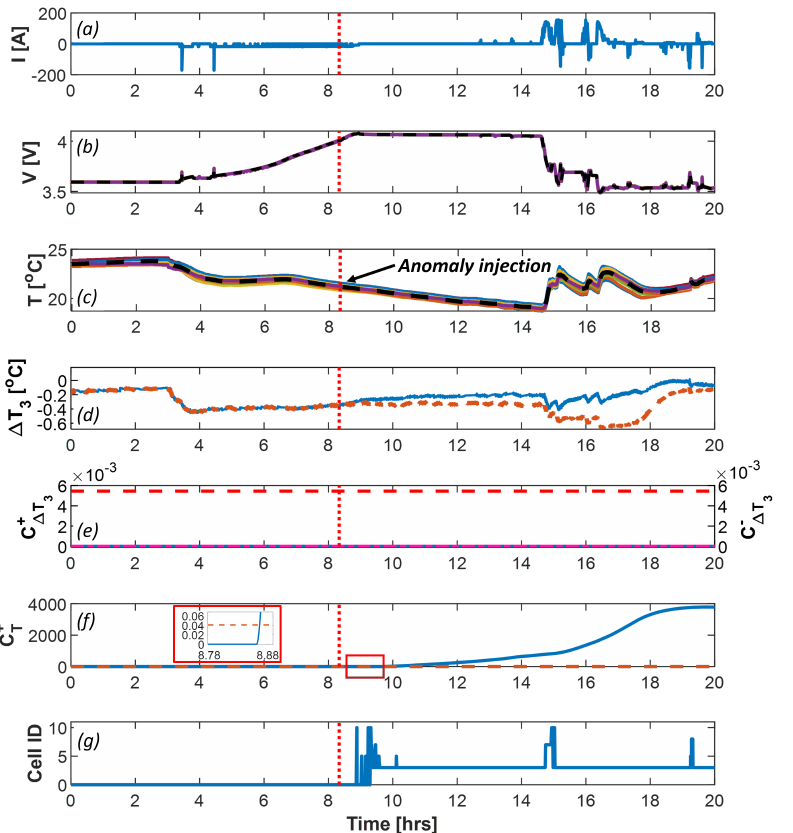
Figure 5. Anomaly detection using PCA (PCA method) and baseline (direct method) approaches for air–flow anomaly ( ϑ = 0.2), with anomaly initiation (dotted) at 8.33 h: ( a ) Input current profile; ( b ) Voltage of 11 cells and mean voltage (dashed); ( c ) Temperature of 11 cells and mean temperature (dashed); ( d ) Nominal (dashed) and anomalous (solid) temperature MBR of cell 3; ( e ) Direct method temperature C + and C − of cell 3 and threshold (dashed); ( f ) Temperature anomaly score from PCA method with threshold (dashed); and ( g ) PCA method tracing of anomalous cell.